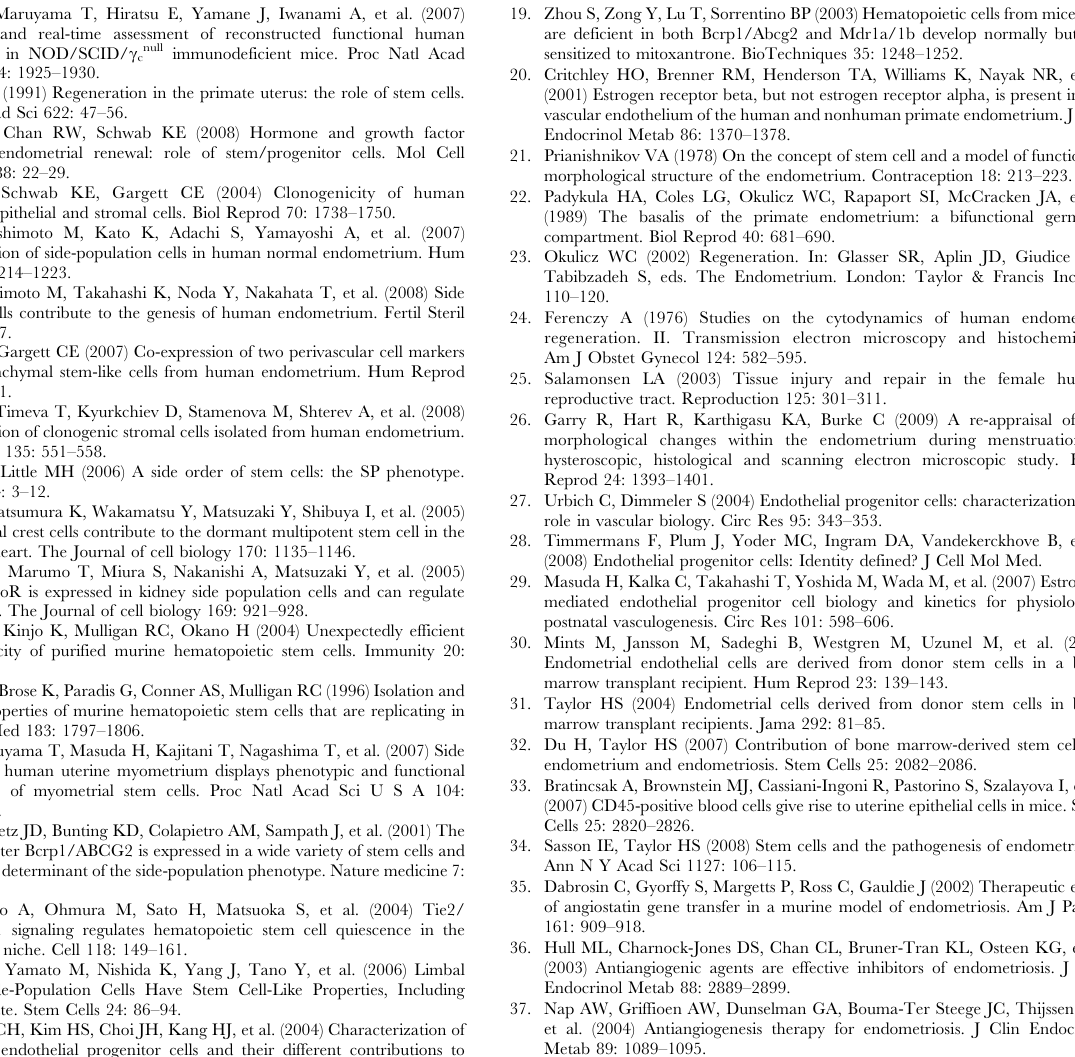
Table S3 List of antibodies used for immunofluorescence